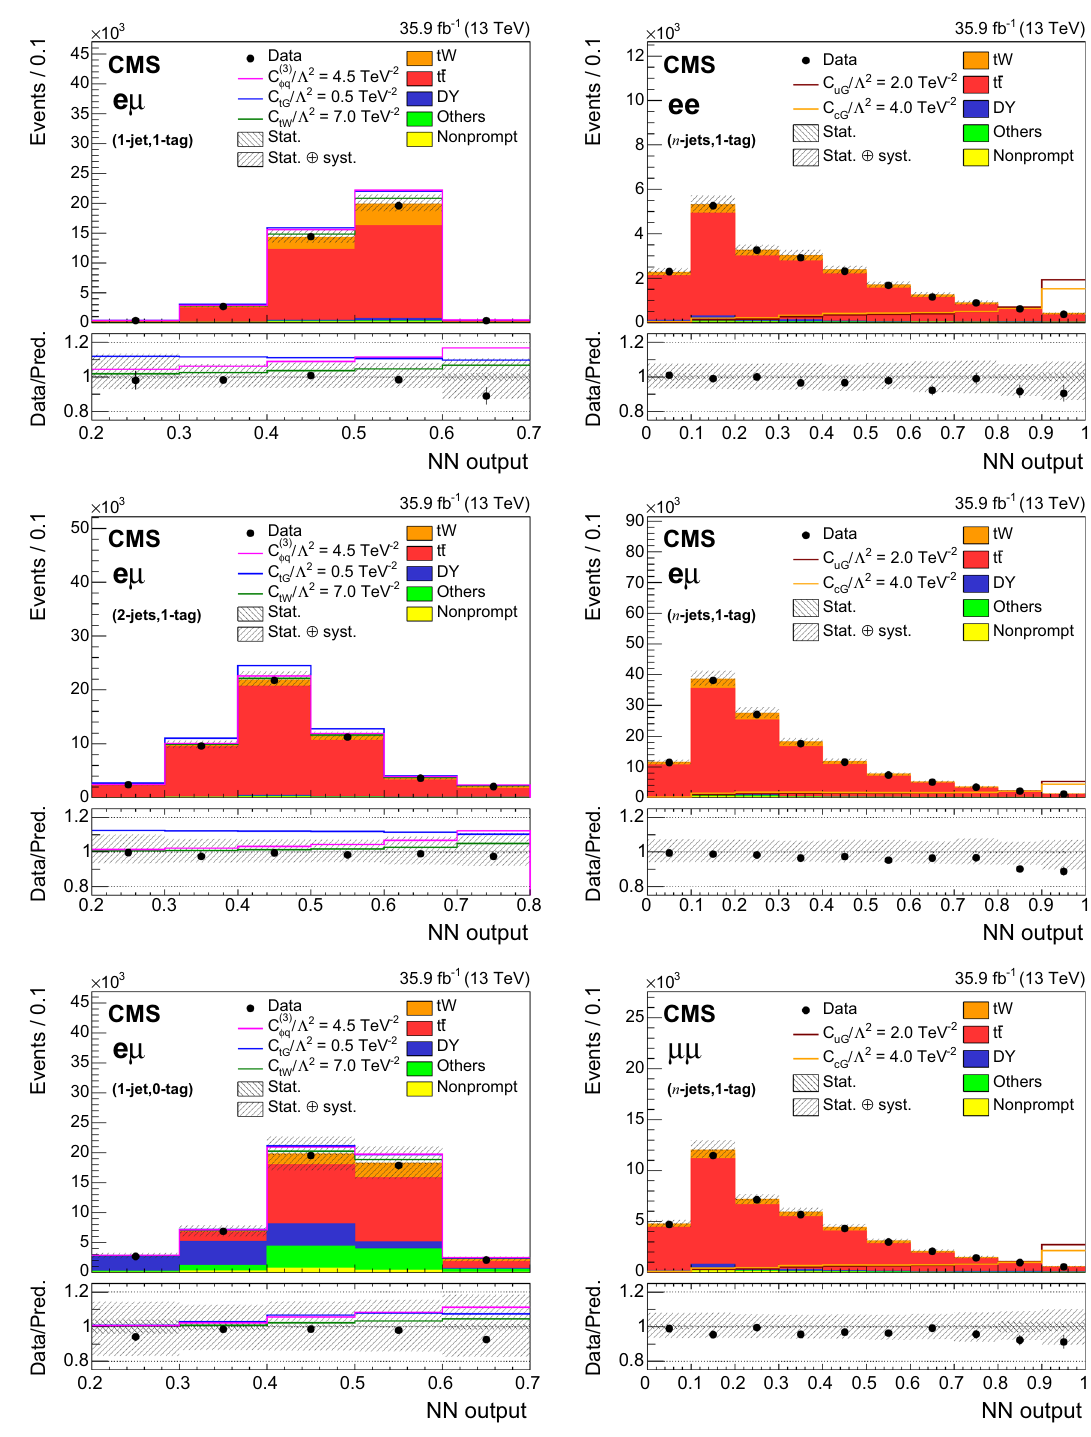
Fig. 4 The NN output distributions for (left) data and simulation for the e μ channel in 1-jet, 1-tag (upper) and 2-jets, 1-tag (middle) and 1- jet, 0-tag (lower) categories; and for (right) data, simulation, and FCNC signals in the n -jets, 1-tag category used in the limit setting for the ee (upper), e μ (middle), and μμ (lower) channels. The hatched bands correspond to the quadratic sum of the statistical and systematic uncer-